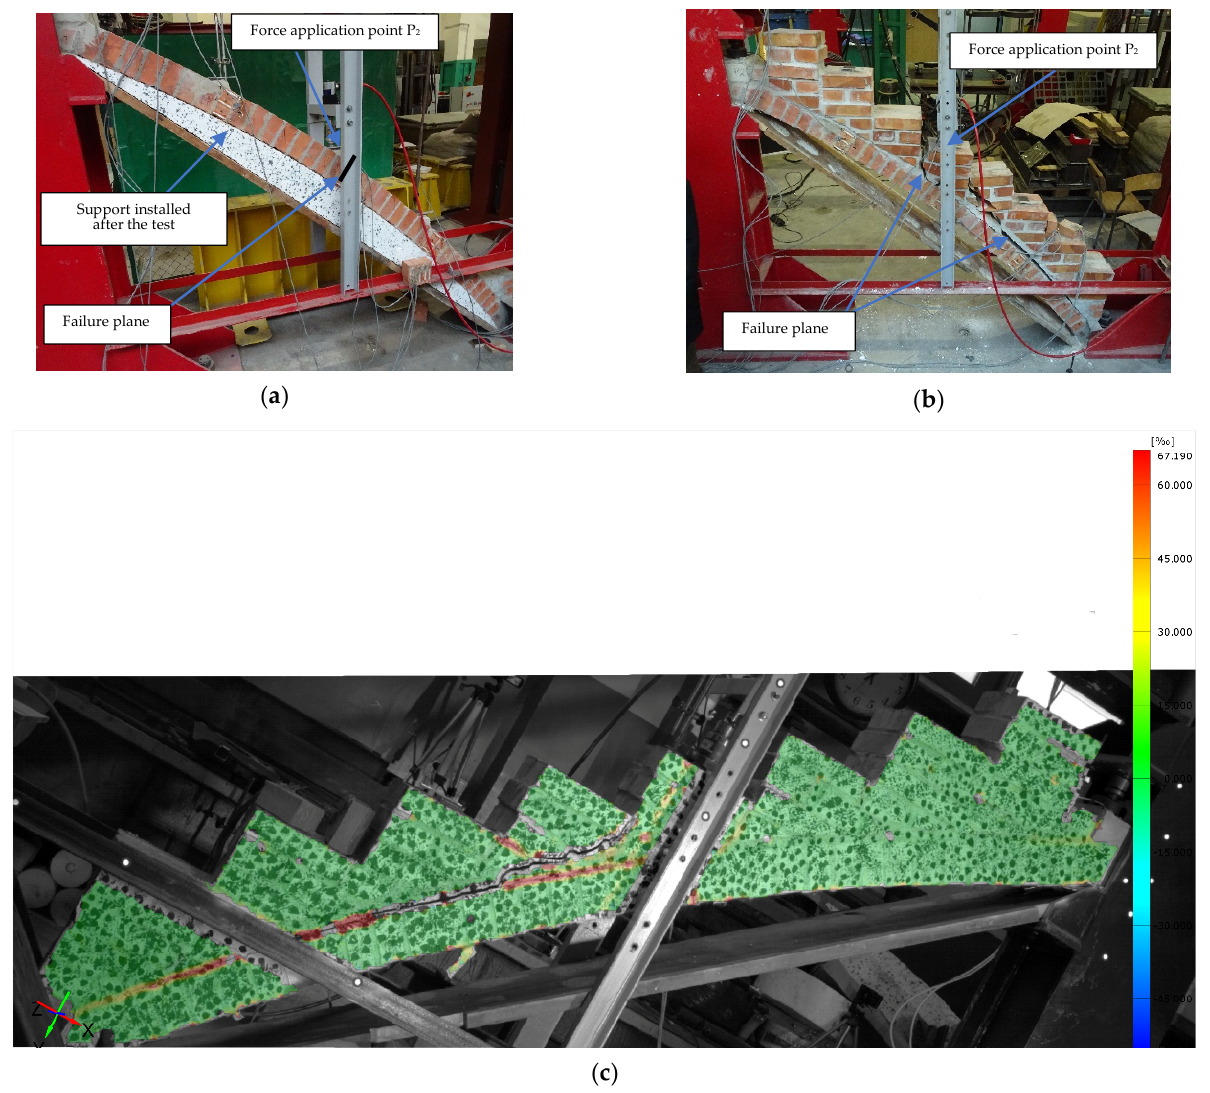
Figure 11. Registered failure mode of tested models of stair arches: model M1 ( a ), model M2 ( b ) and measurements from ARAMIS of deformation during failure of model M2 ( c ).